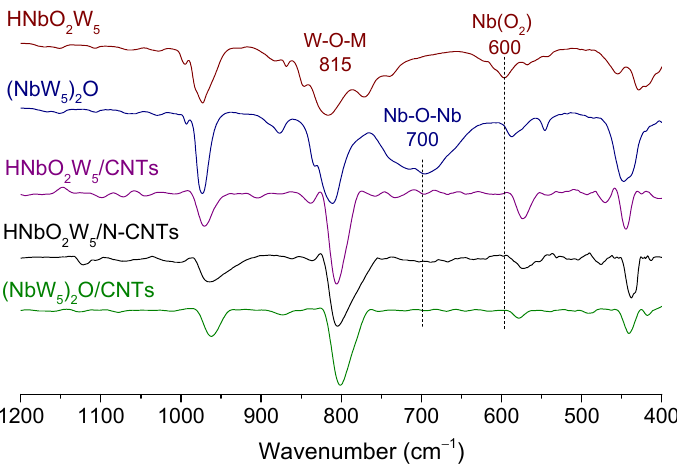
Figure 8. FTIR spectra of TBA 2 [HNbW 5 (O 2 )O 18 ], TBA 4 [(NbW 5 O 18 ) 2 O], 15 wt. % [HNbW 5 (O 2 )O 18 ]/CNTs, 15 wt. % [HNbW 5 (O 2 )O 18 ]/N-CNTs (0.9 at. % N), and 15 wt. % [(NbW 5 O 18 ) 2 O]/CNTs (spectrum of (N)-CNTs was subtracted). Reproduced from Ref. [103] with permission from the Royal Society of Chemistry.